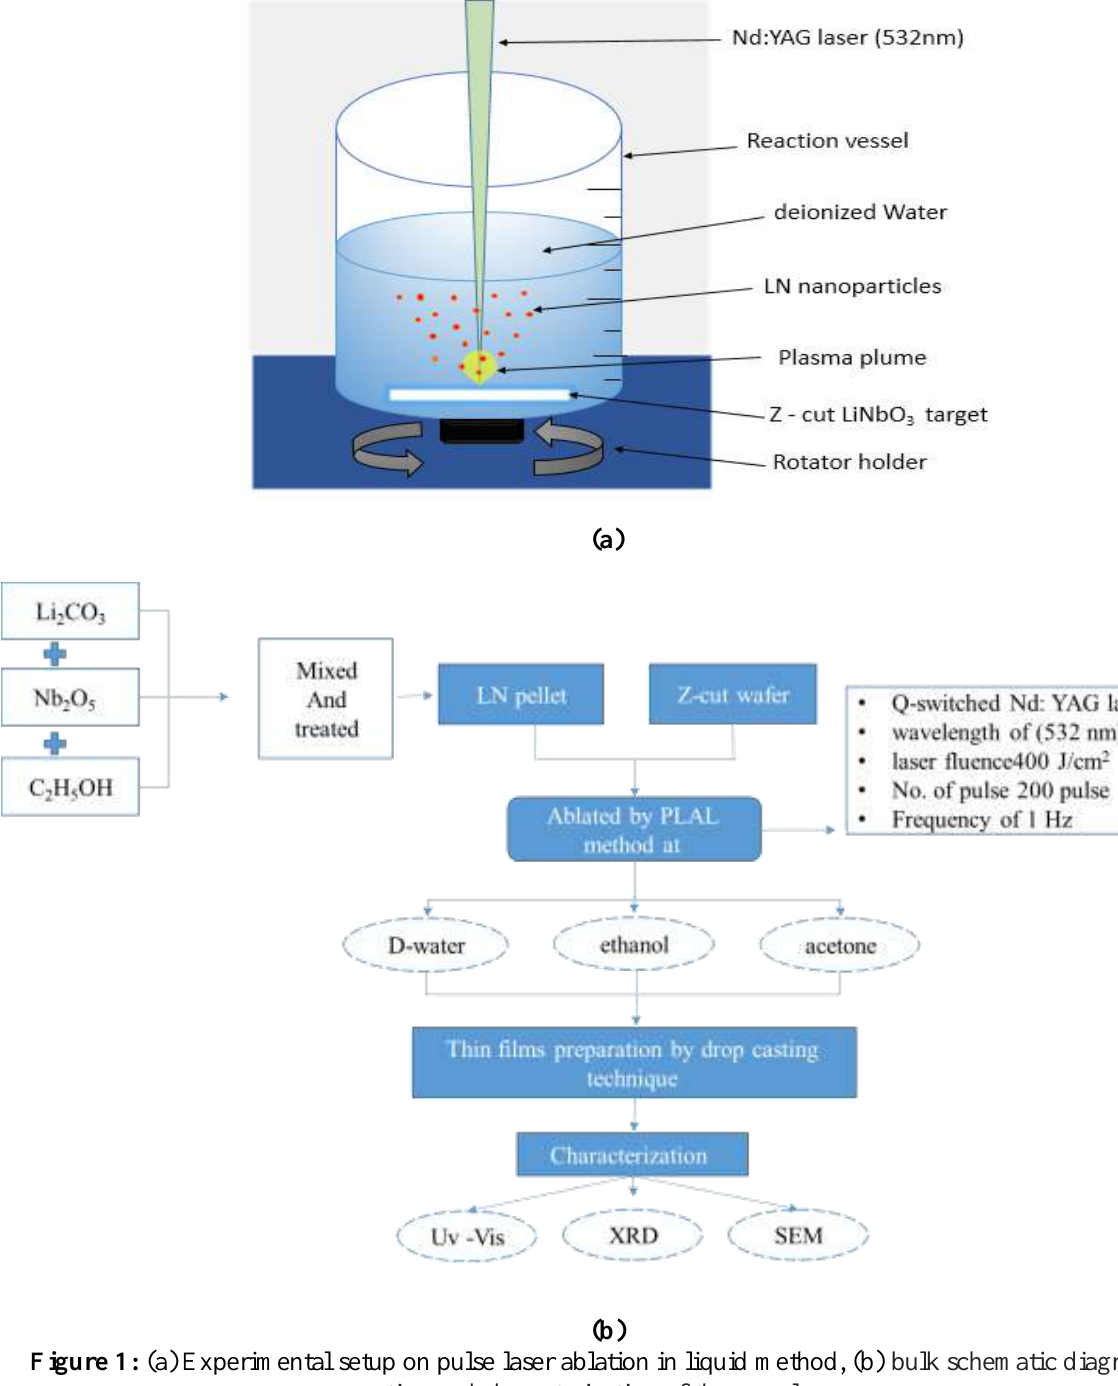
Figure 1: (a) Experimental setup on pulse laser ablation in liquid method, (b) bulk schematic diagram of preparation and characterization of the